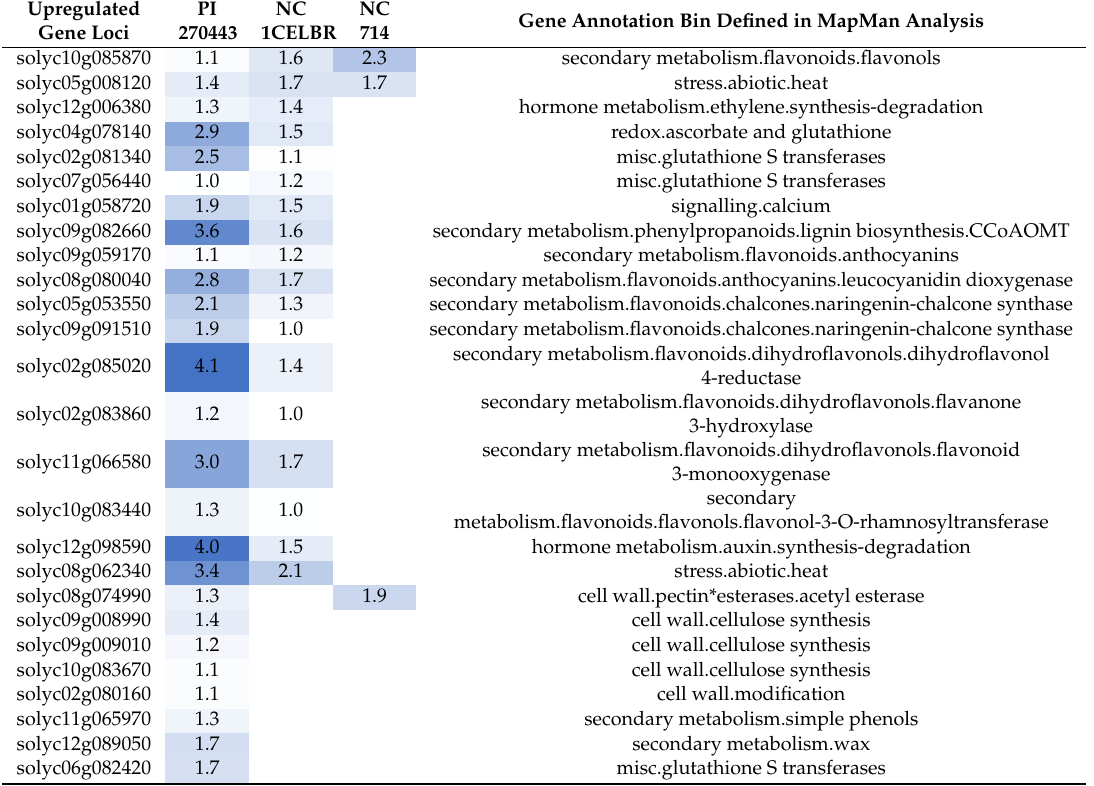
Table 3. DEGs in the biotic stress pathway associated with resistance and susceptibility. The upper part of the table lists all upregulated biotic stress pathway DEGs in three lines with expression change (log2) between inoculated and control samples, and the lower part of the table list all downregulated biotic stress pathway DEGs in the susceptible line NC 714. Expression change in the blue and red background is for upregulated and downregulated DEGs, respectively. The intensity of the two colors indicates the level of expression of genes changes in both